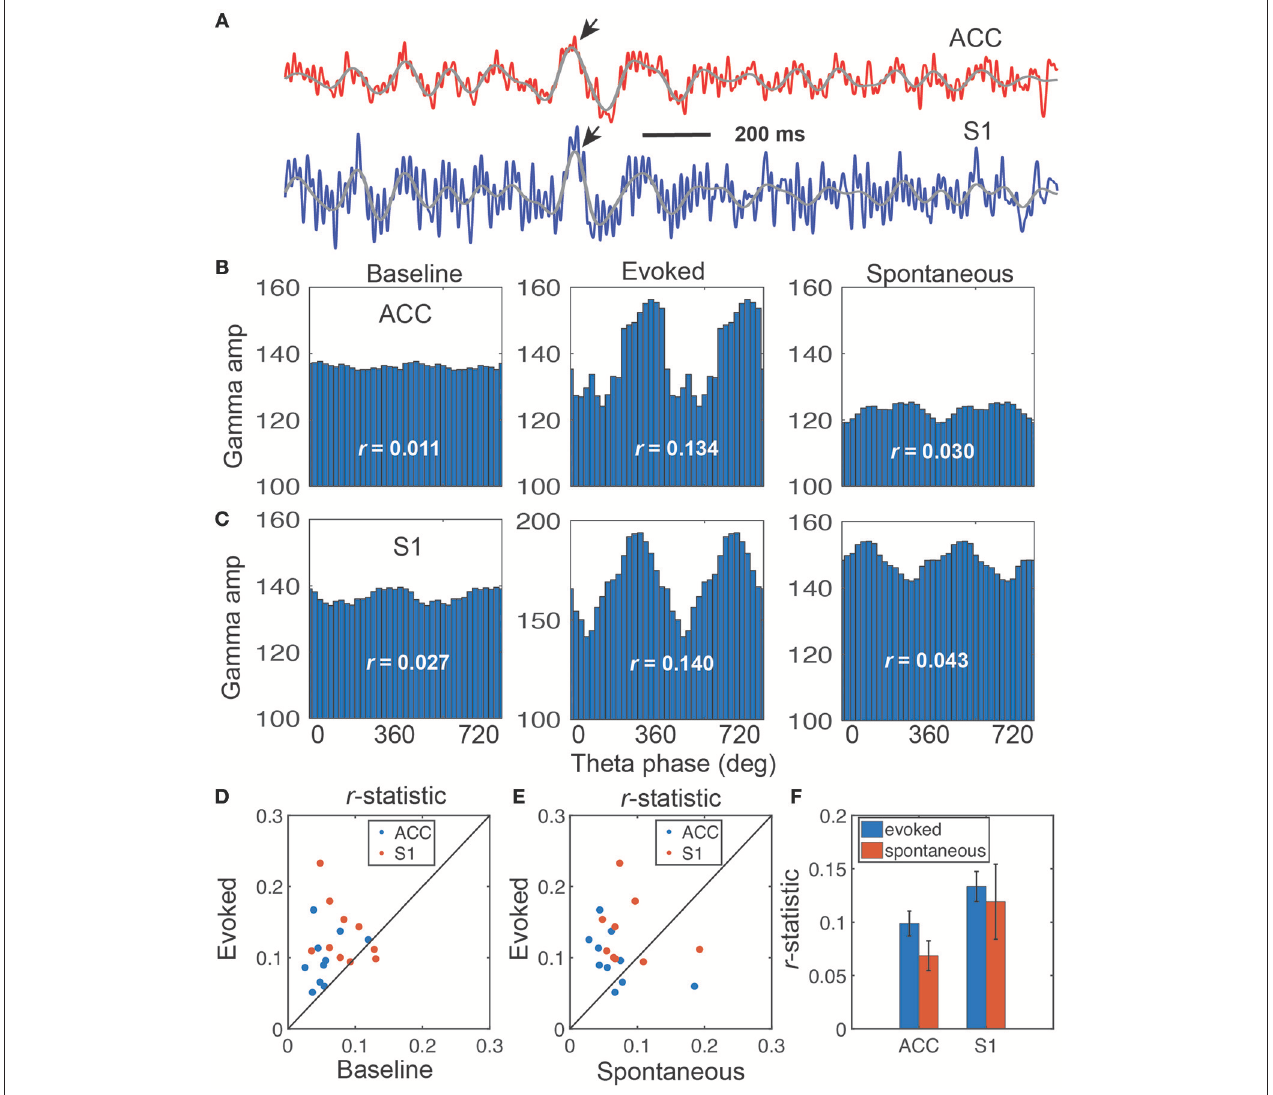
FIGURE 3 | Illustration of coupling between the theta phase and gamma amplitude. (A) Representative LFP traces from the rat ACC (red) and S1 (blue), which shows strong coupling between the theta phase and gamma amplitude (rat #15). Two arrows indicate the identified ERPs, and two overlaid gray traces indicate the bandpass filtered (4–11 Hz) LFP traces. (B,C) Coupling of gamma amplitude and theta phase (0–720 ◦ ) in the ACC (B) and S1 (C) : baseline (left), evoked pain (middle), and spontaneous pain (right). In each panel, the r -statistic is shown. (D) Scatter plot comparison of r -statistic (red: ACC, blue: S1) between evoked pain and baseline ( n 10 sessions, rats #12–15). Paired signed-rank test, p 0.0013. (E) Scatter plot comparison of r -statistic (red: ACC, blue: S1) between evoked pain and = = spontaneous pain-like episodes ( n 10 sessions). Paired signed-rank test, p 0.079. (F) Comparison of r -statistic in the S1 and ACC. Error bar denotes SEM = = ( n 10 =